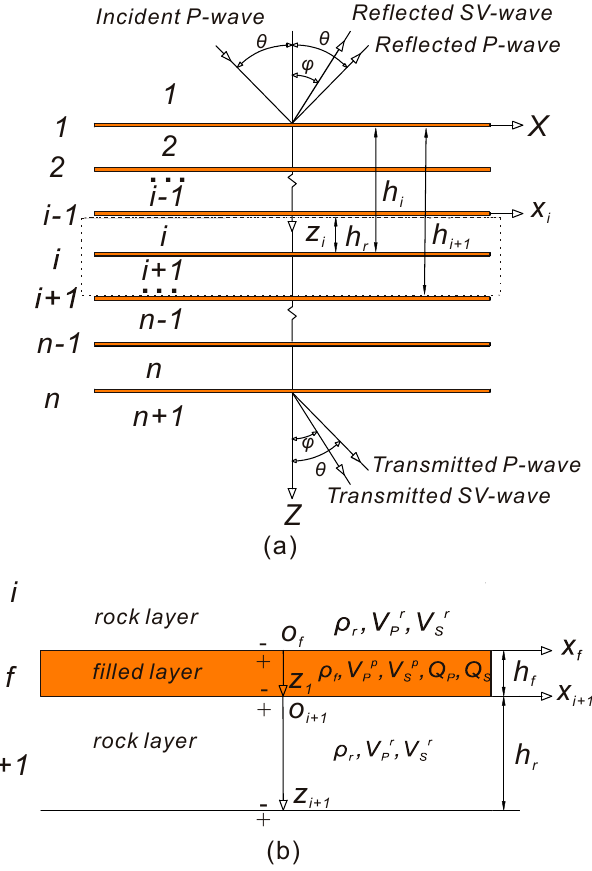
Figure 1. ( a ) A P wave impinges on a rock mass containing joints filled with a viscoelastic medium, ( b ) the schematic view of the sandwiched element.